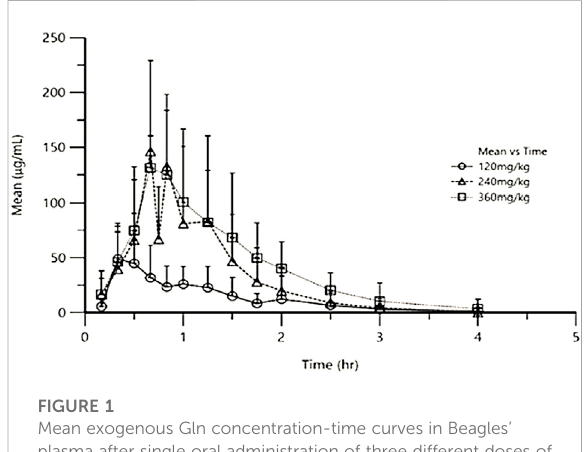
FIGURE 1 Mean exogenous Gln concentration-time curves in Beagles ’ plasma after single oral administration of three different doses of Gln tablets. Beagles, the mean plasma concentration-time curve of exogenous Gln was shown in Figure 1 and the mean pharmacokinetic parameters (mean ± SD) were shown in Table 2.